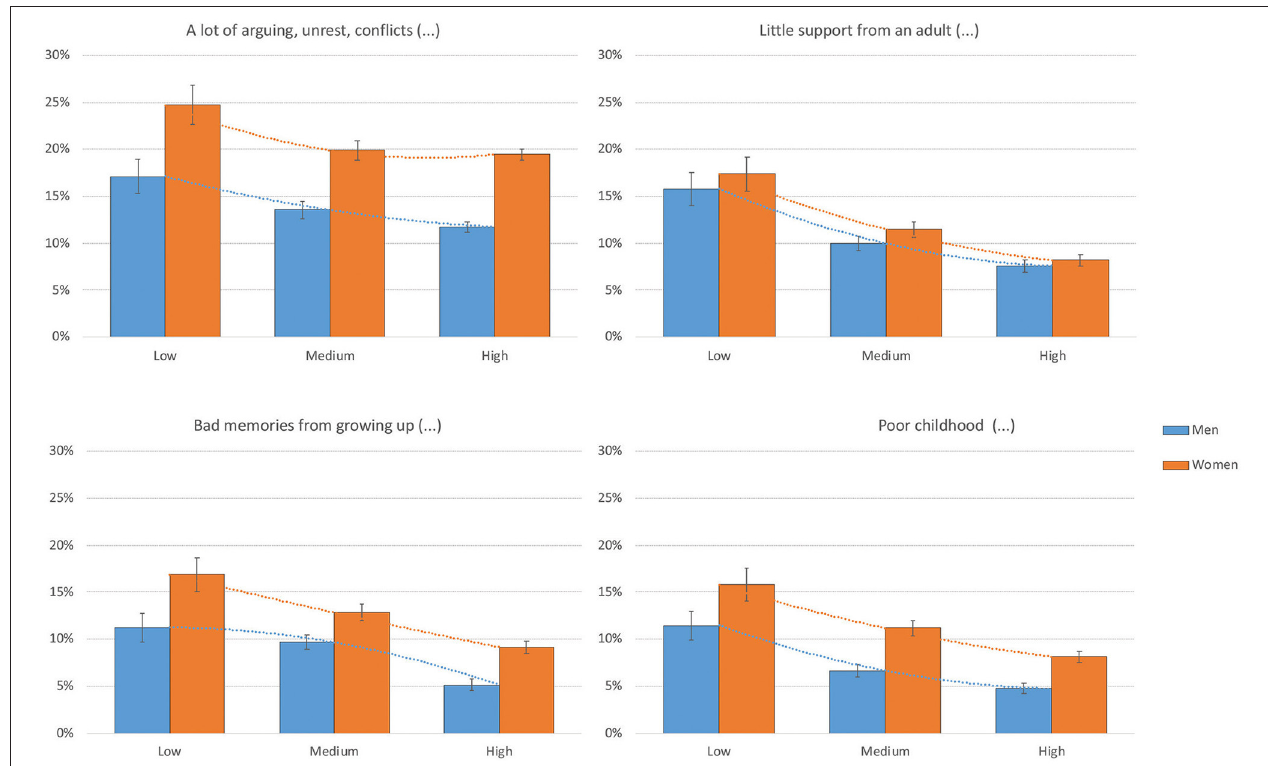
FIGURE 2 | The prevalence of ACEs among Norwegian adults from a general population, grouped by education. Data retrieved from the Norwegian Counties Public Health Survey conducted in Agder,